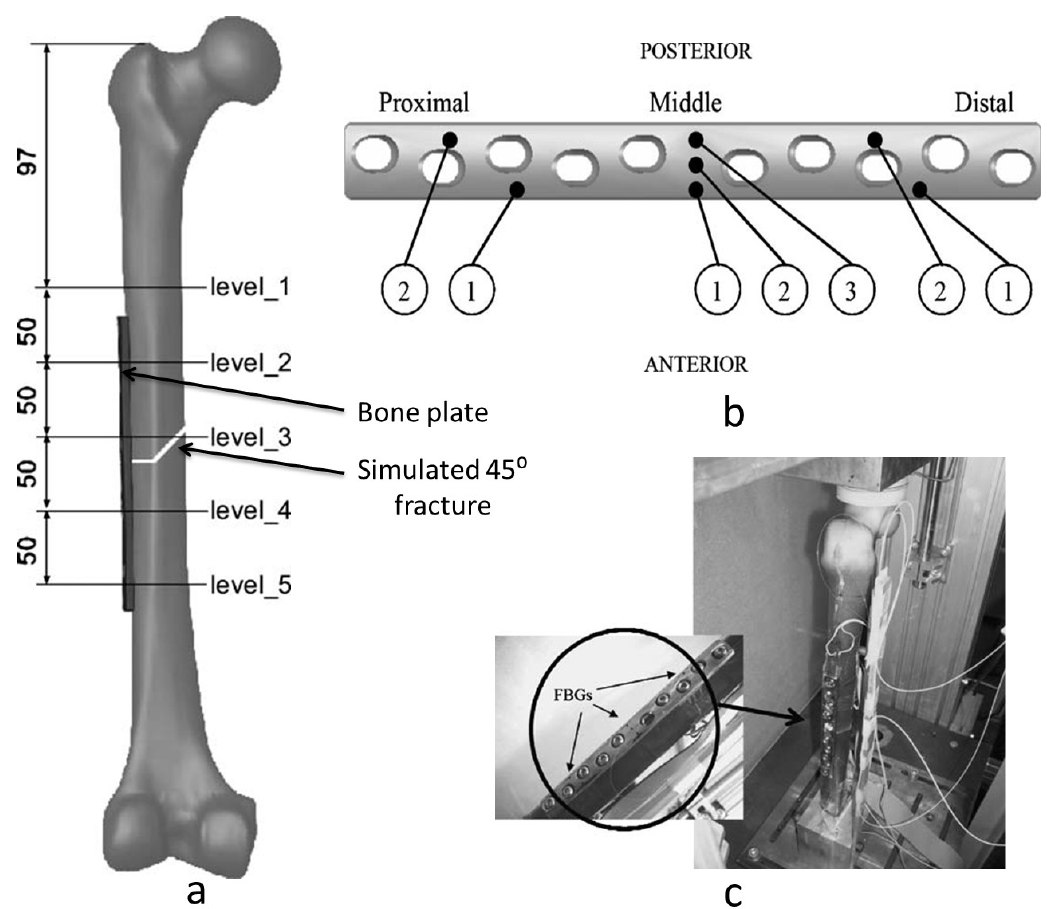
Figure 2. ( a ) The simulated 45° fracture and the locations of the SGs on the intact and plated synthetic Femurs. ( b ) The locations of the FBGs on the bone plate. ( c ) Representation of the experimental apparatus used and detail of bone plate with FBGs